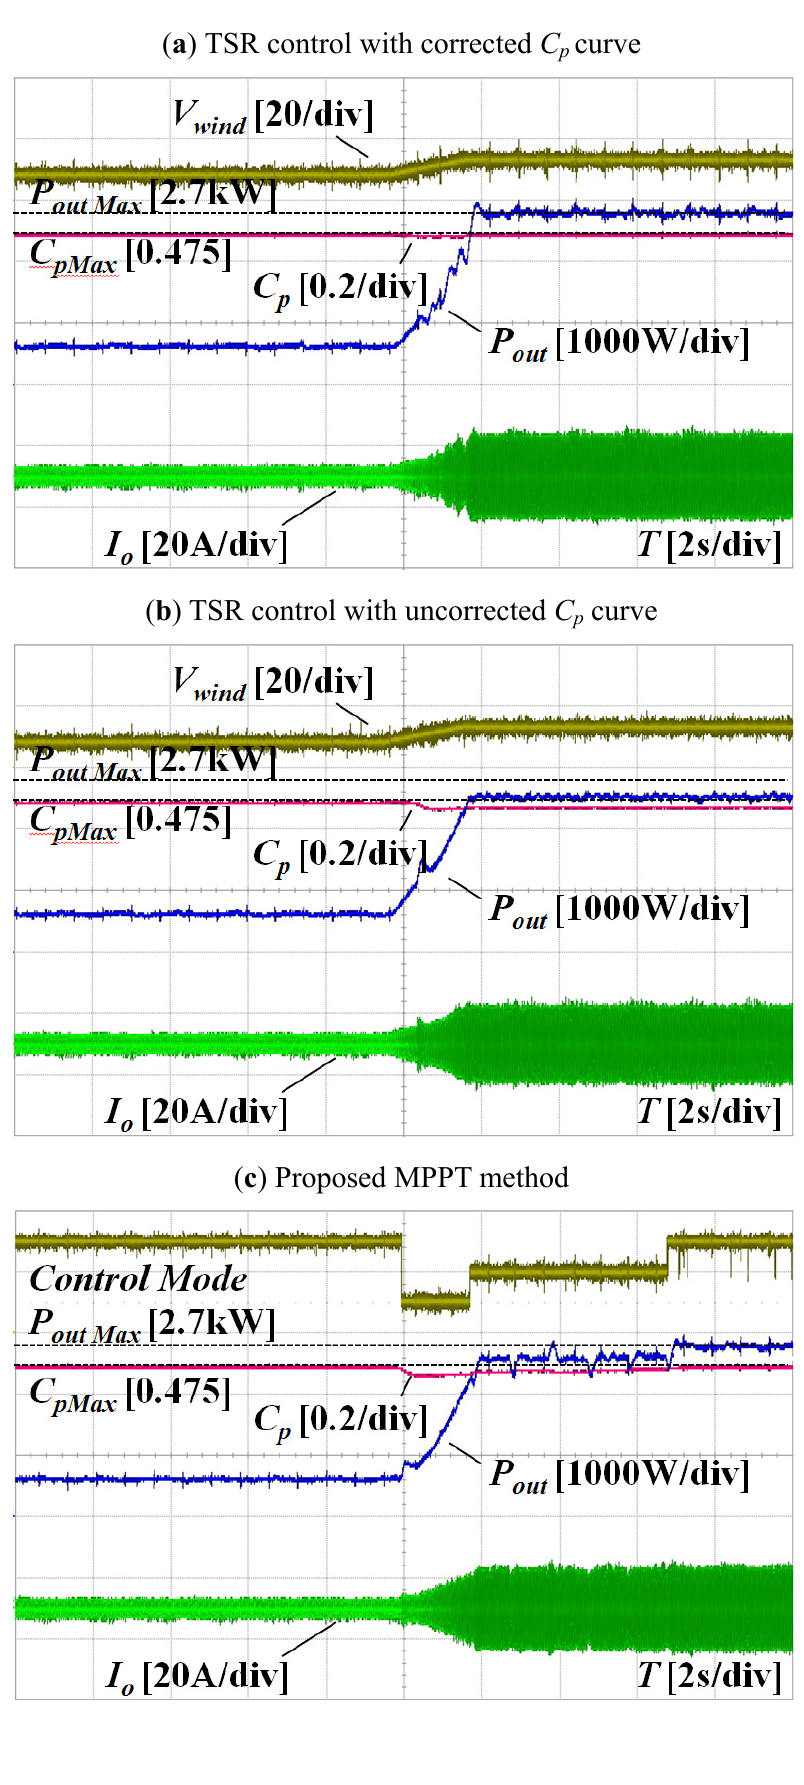
Figure 13. Full operation of the wind power system with the proposed MPPT